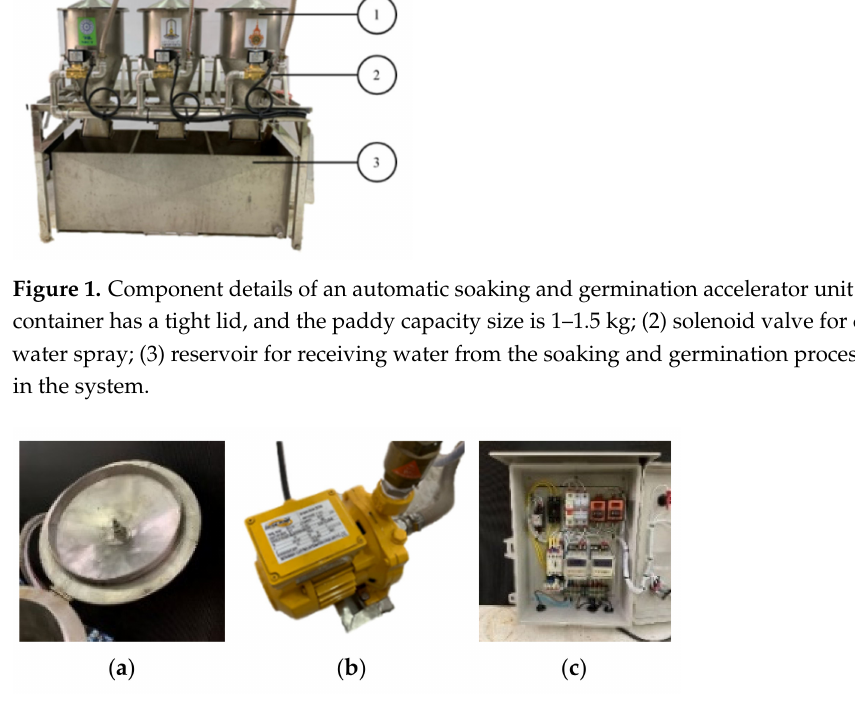
Figure 2. Spiral spray nozzle ( a ), centrifugal pump ( b ), and automatic control system unit ( c